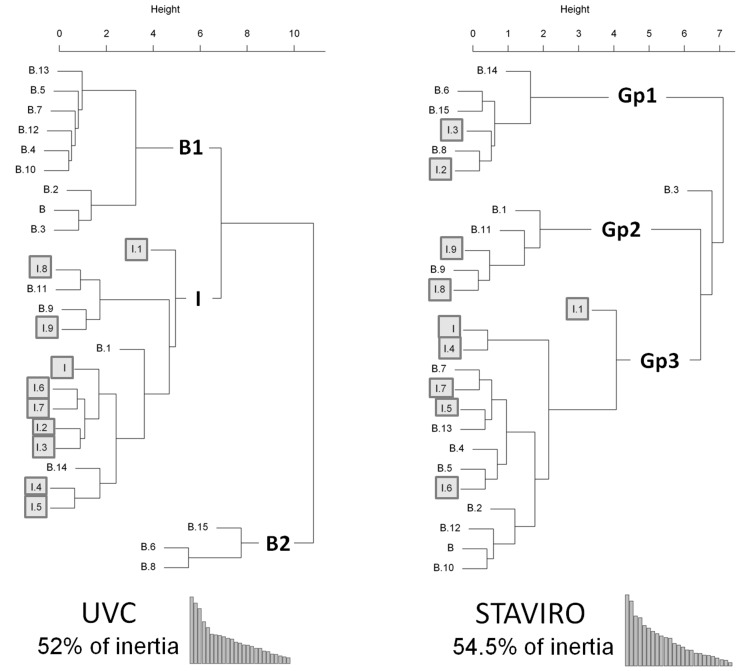
Dendrogram of the stations.B: Barrier reef and I: Intermediate reef. Clusters are represented on the graph in bold: B1 = 1st cluster on the barrier reef; I = cluster on the intermediate reef; B2 = 2nd cluster on the barrier reef; Gp1, 2 and 3 = clusters not explained by habitat characteristics. Intermediate reef stations are in grey and barrier reef stations are in white.